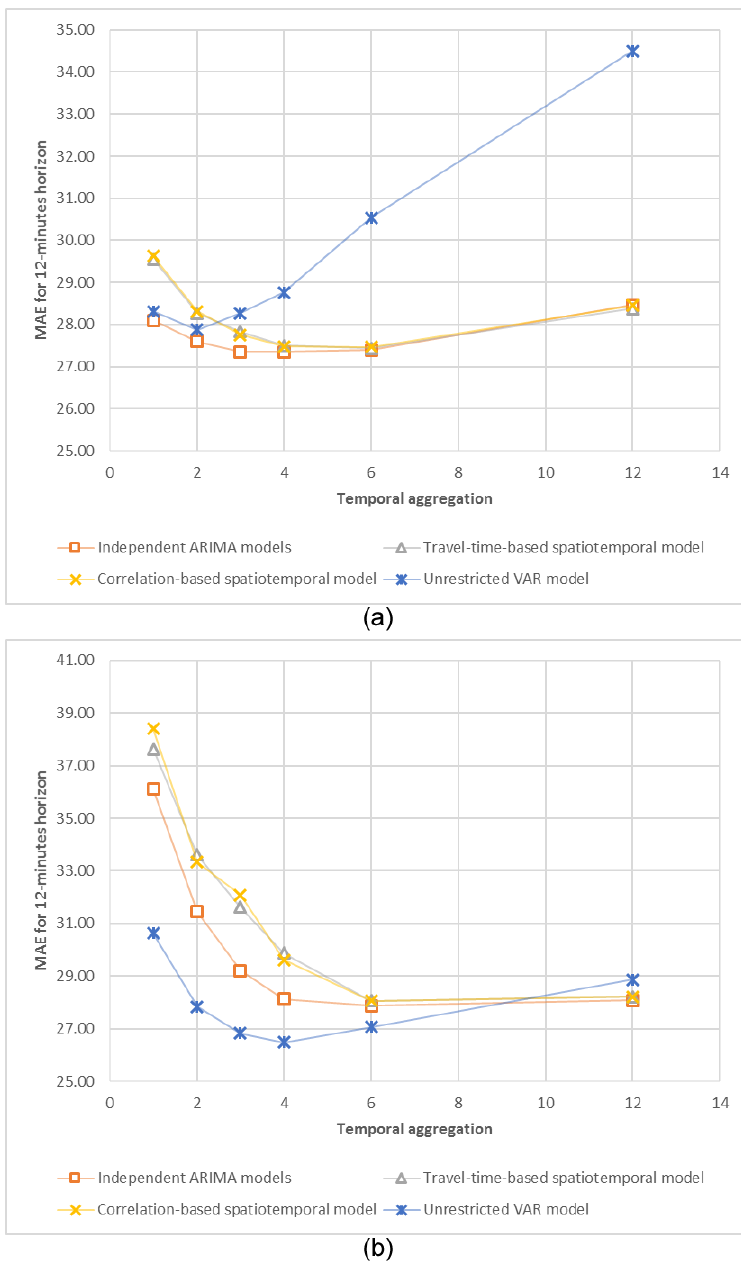
Figure 6. MAE values for 12 min forecasts for different temporal aggregation levels: ( a ) detrended traffic volume, the complex spatial structure, ( b ) detrended traffic volume, the sequential spatial structure.